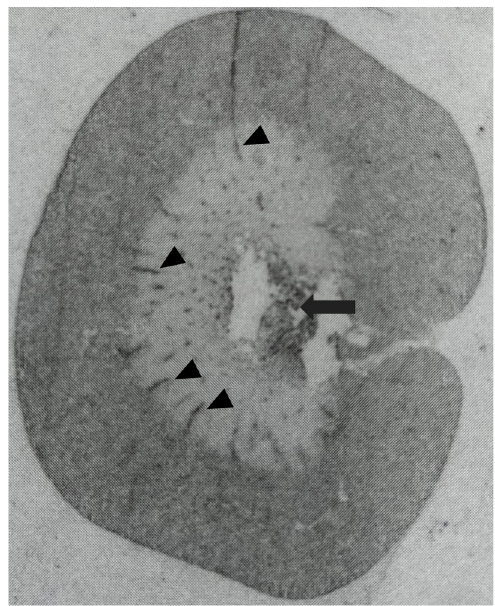
Figure 1. In situ ‐ autoradiography showing distribution of radiolabeled insulin binding sites in the kidney of a normal Wistar ‐ Kyoto rat. Insulin binding was greater in the renal cortex, where it was comparable in tubules and glomeruli that could not be distinguished from the surrounding tissue. In the renal medulla, radioligand binding was detected primarily in longitudinal structures crossing the outer portion, presumably corresponding to interlobar vessels (black arrowheads), and the inner portion, presumably corresponding to hilar fat (black arrow).